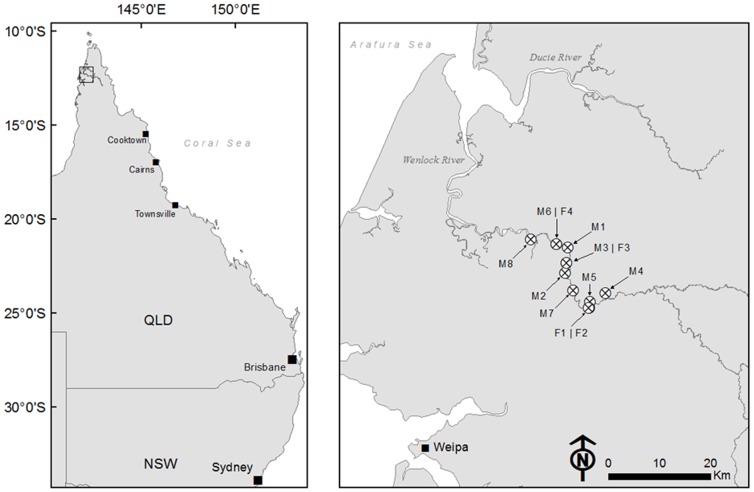
The Wenlock and Ducie River, Cape York, QLD, Australia.The capture locations of each Crocodylus porosus tagged for the study are displayed.